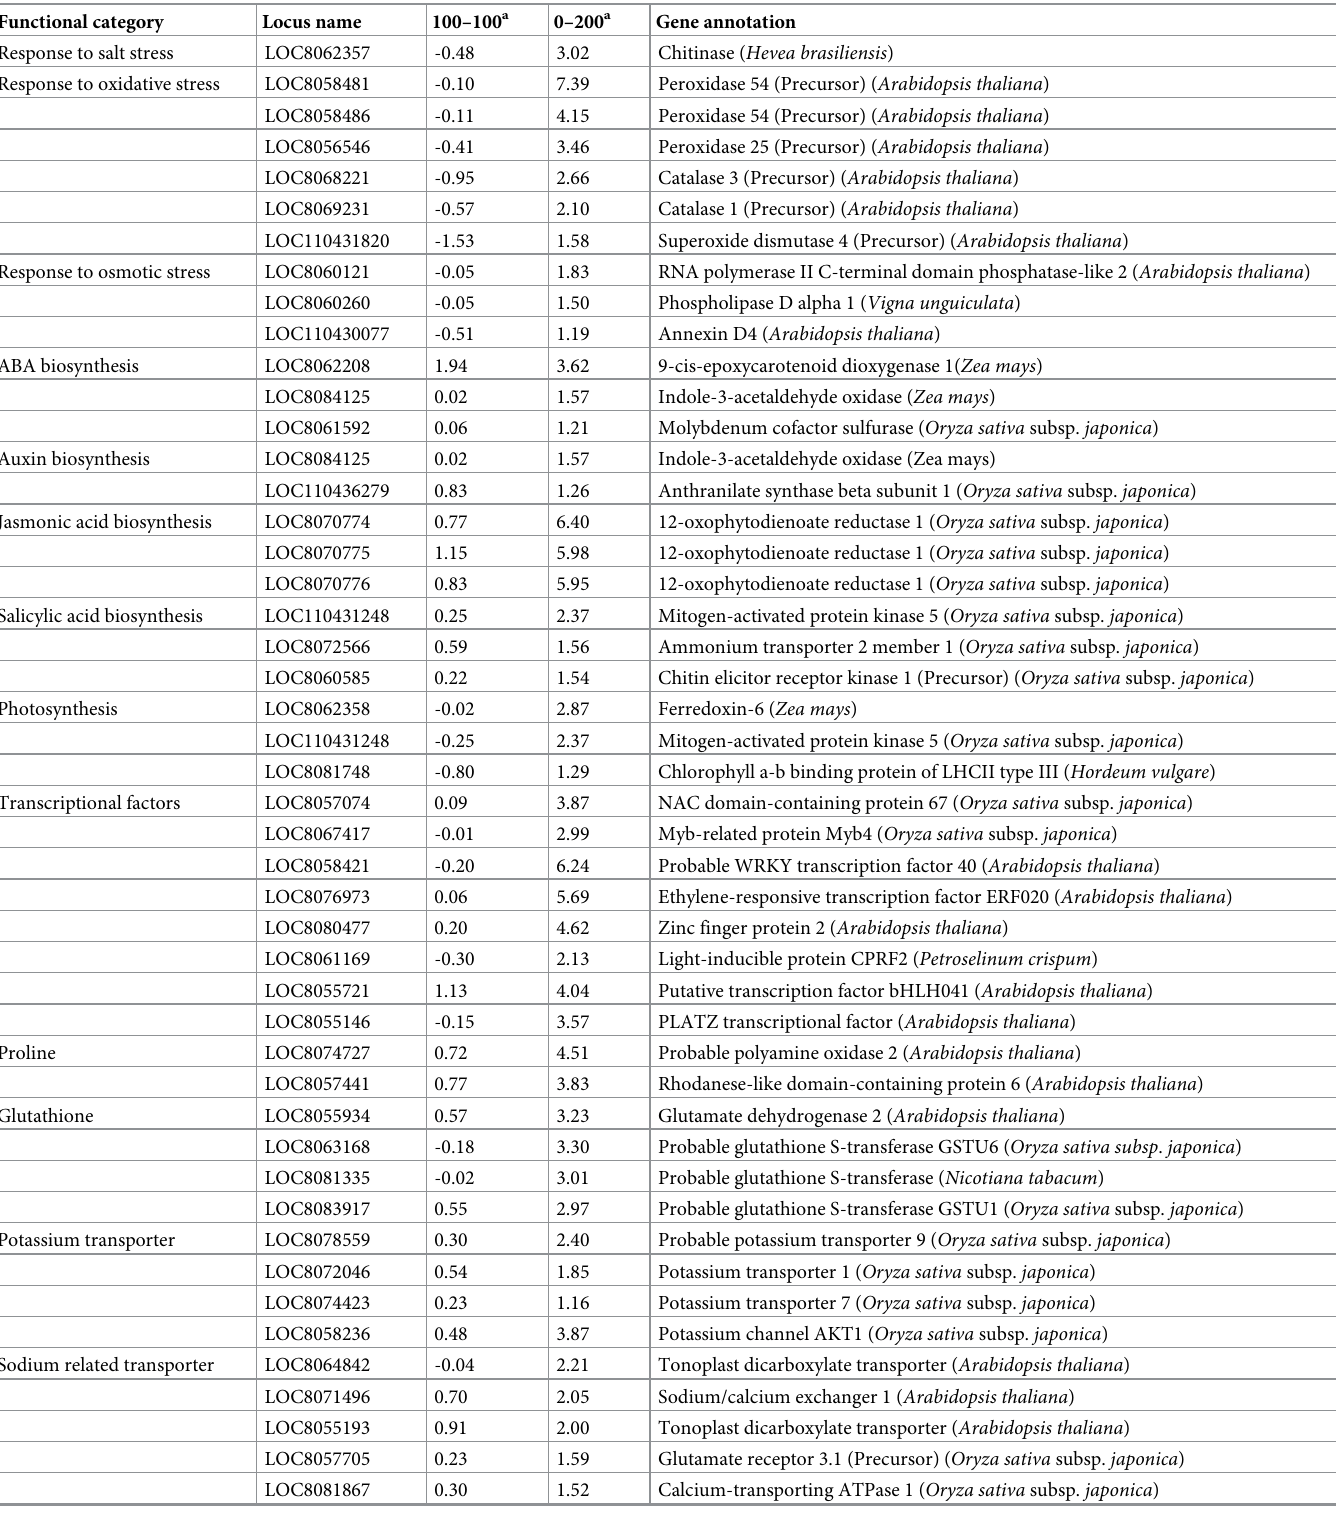
Table 1. Summary of differentially expressed genes in leaves up-regulated under non-uniform salinity condition. Functional